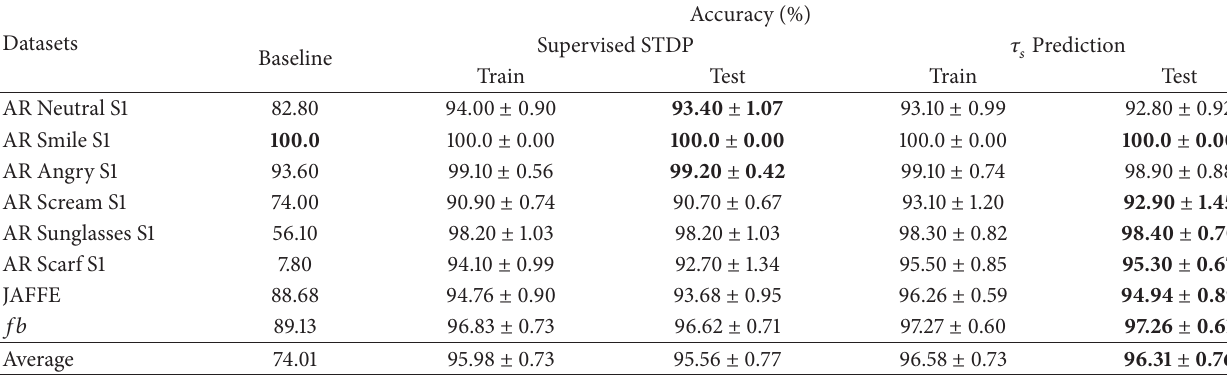
Table 2: Result of face recognition accuracy using CD classifier with Supervised STDP and 𝜏 𝑠